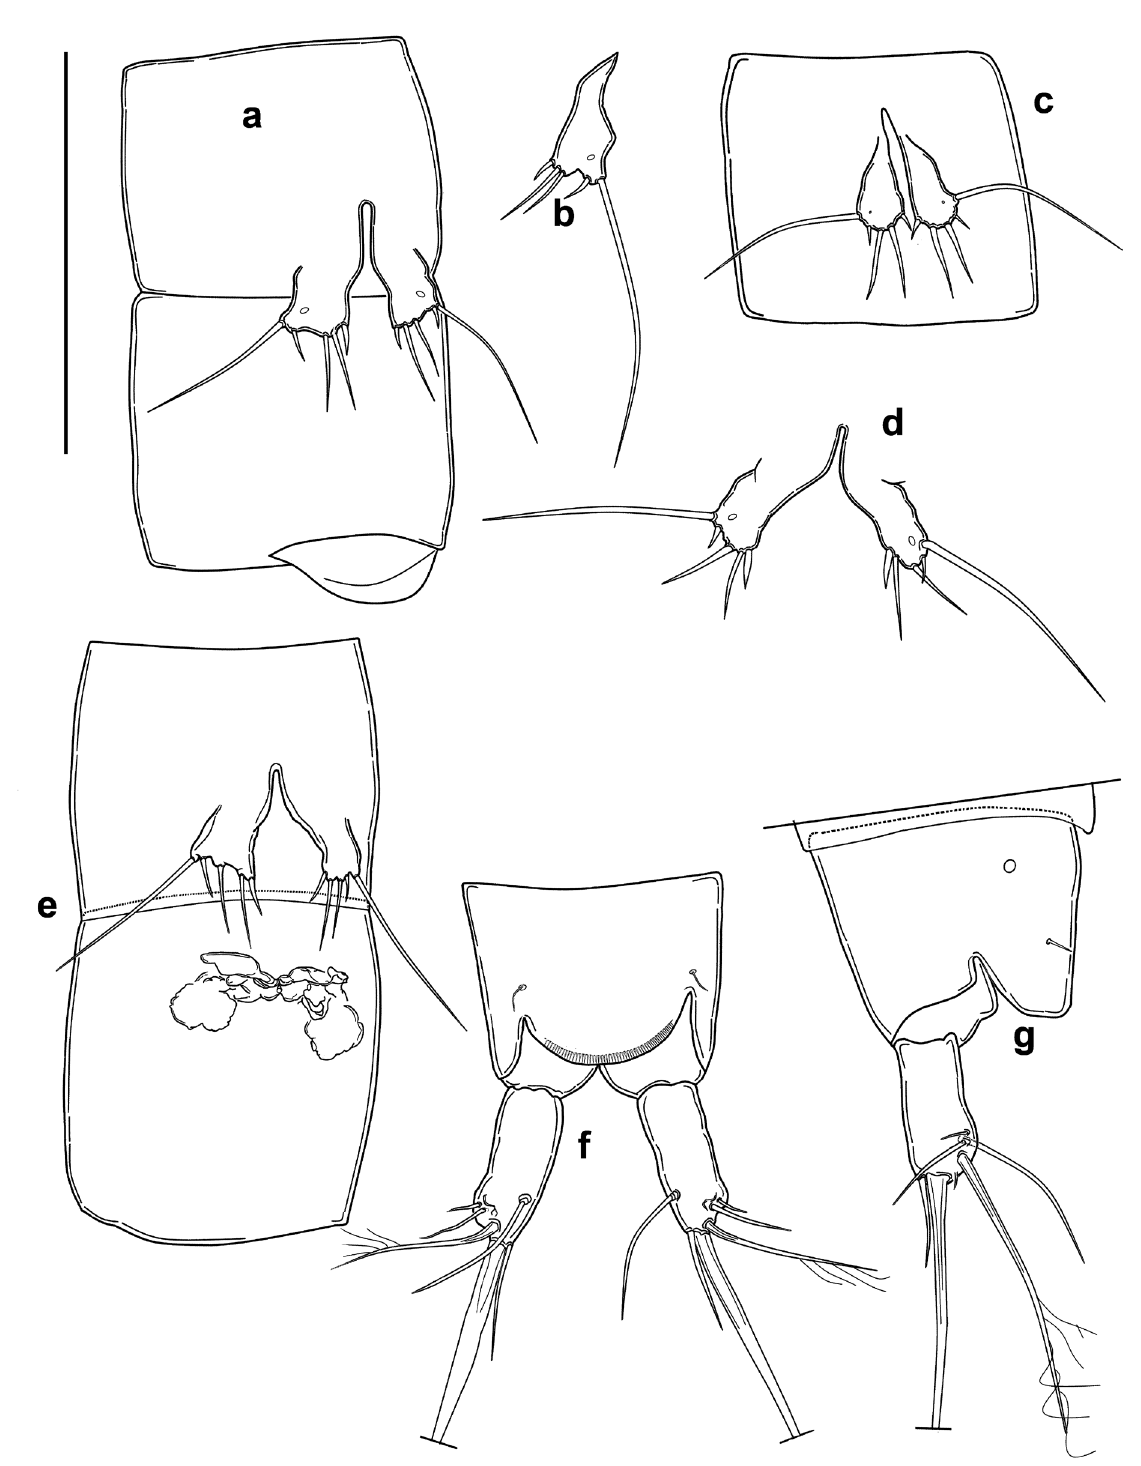
Fig. 6. Cottarellicaris sanctiangeli Bruno & Cottarelli sp. nov. (NHMUK). a . ♂, P5, P6, first and second urosomites, ventral view. b . ♂, P5. c . ♂, P5 and first urosomite, ventral view. d . ♂, P5. e . ♀, first urosomite, P5, P6, genital double-somite and genital field, ventral view. f . ♀, anal somite, anal operculum and caudal rami, dorsal view. g . ♀, anal somite, anal operculum and caudal rami, lateral view. a–b, e, g: Grotta Vucco Ucciardo; c: Grotta del Banco di ferro; d, f: Grotta superiore di Sant’Angelo. Scale bar: 50